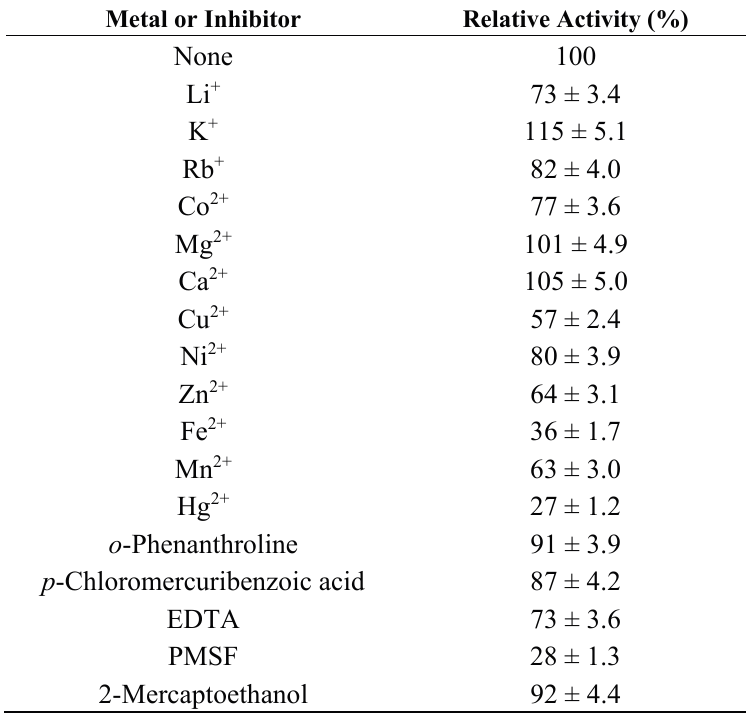
Table 5. Effects of metals and inhibitors on the HydS14